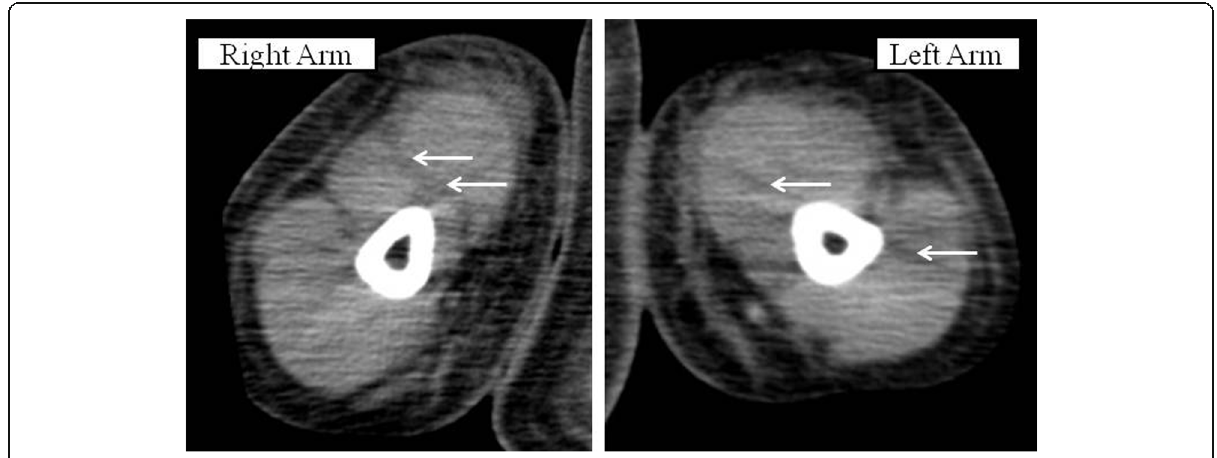
Fig. 4 Computed tomography images of the forearms. Non-contrast CT images show edema between the muscles (white